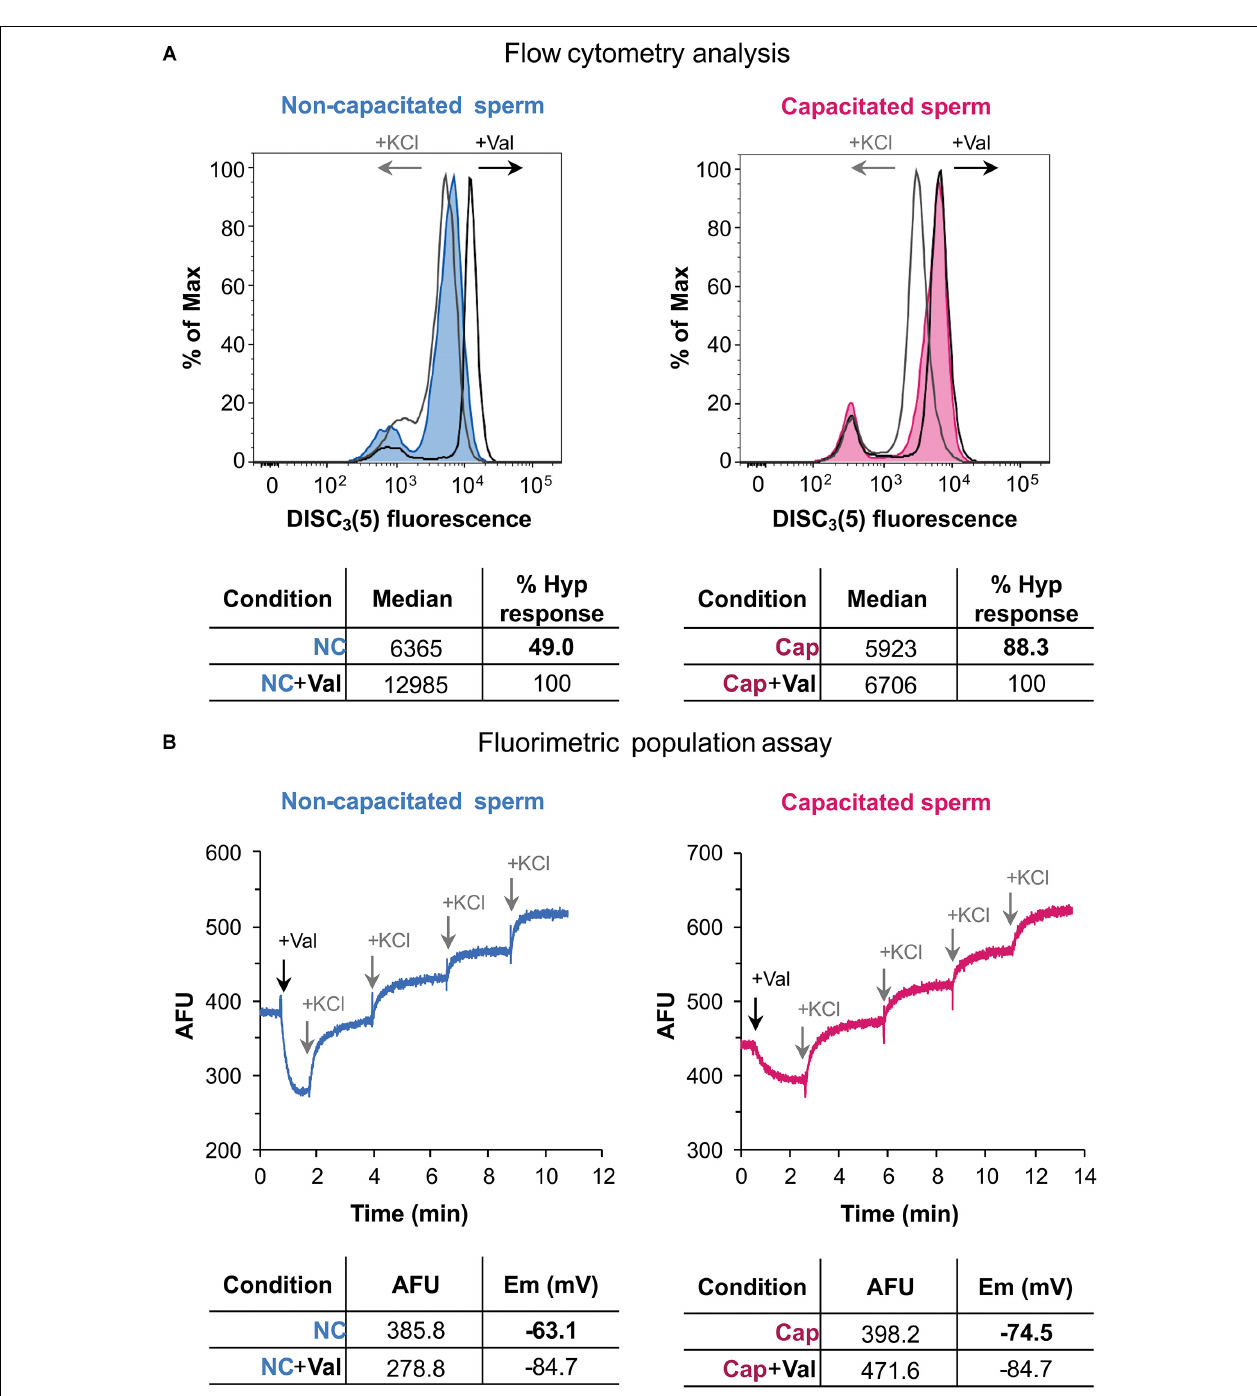
FIGURE 4 | Human sperm membrane potential determination by flow cytometry and population fluorimetry. (A) Flow cytometry analysis of human sperm in non-capacitating (left panel) and capacitating conditions (right panel). Valinomycin addition causes an increase of fluorescence, in accordance to a hyperpolarized state; KCl addition causes a decrease of fluorescence, as expected for a depolarized state. Each histogram plots percentage of maximum (% of Max) vs. DiSC3(5) fluorescence, obtained by normalizing to the peak height at the mode of the distribution – so the maximum Y -axis value in the absolute-count histogram becomes 100% of total. Lower panel shows median values obtained before and after valinomycin addition. Hyperpolarization response is normalized against valinomycin addition. (B) Population fluorimetric assay of human sperm in non-capacitating (left panel) and capacitating conditions (right panel). In this case valinomycin addition causes a decrease in fluorescence, as expected for a hyperpolarized state; KCl sequential additions increase extracellular fluorescence, depolarizing the sample. Lower panel shows fluorescence values for initial and hyperpolarized states, with their corresponding membrane potential value (in mV). These results are representative of one experiment ( n =